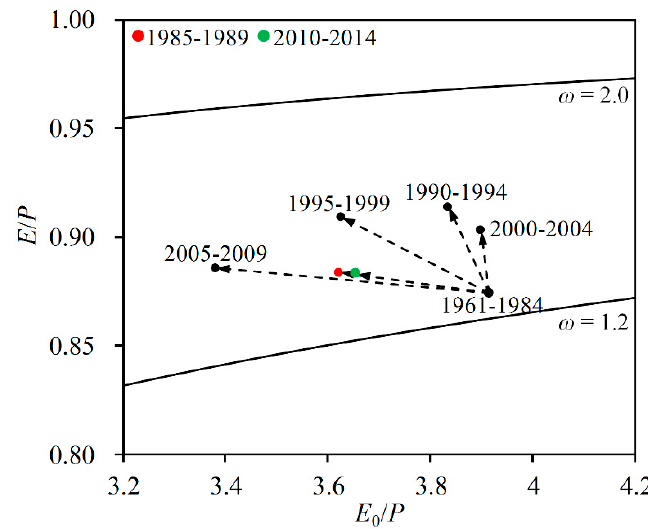
Figure 4. Paths from the baseline period of 1961–1984 to the six sub-variation periods based on the Budyko framework.